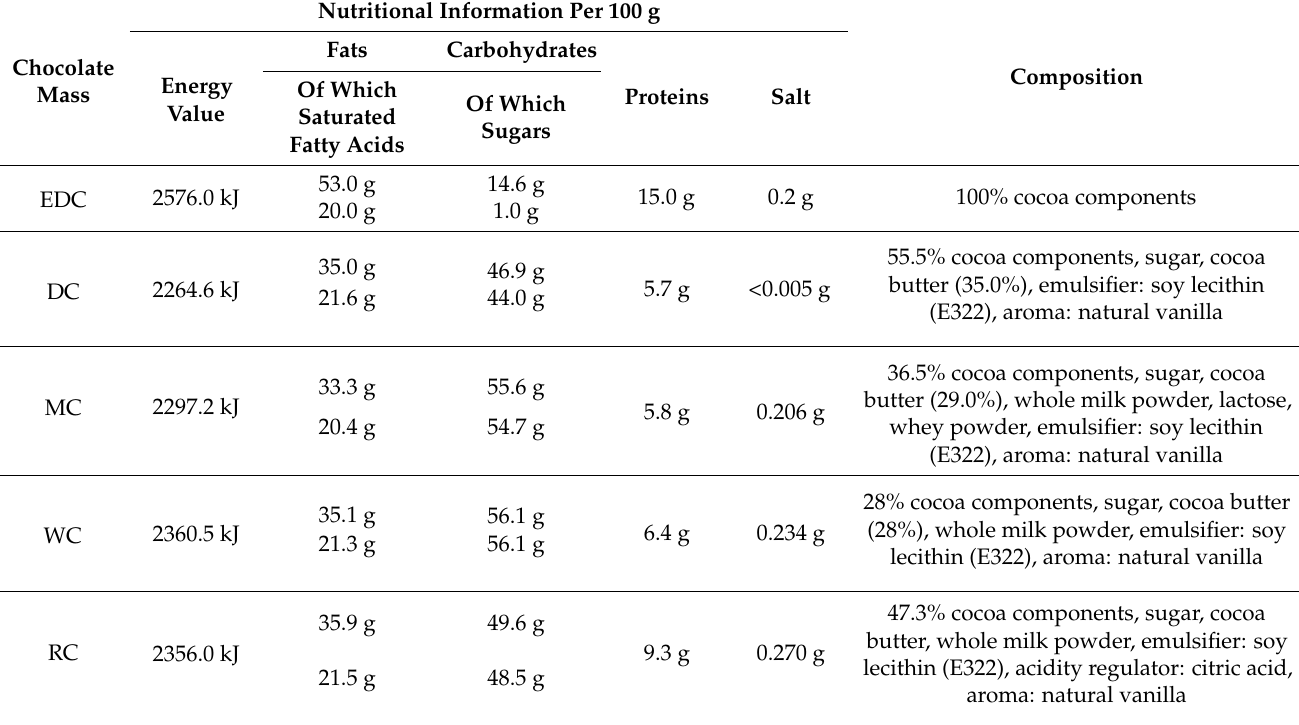
Table 1. Nutritional data of the chocolate masses.